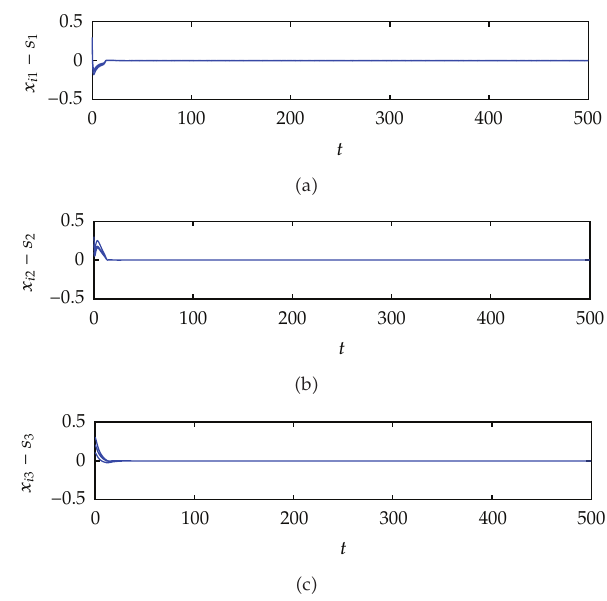
Figure 2: Synchronization errors x ir − s r (cid:2) 1 ≤ i ≤ 3 , 1 ≤ r ≤ 3 (cid:3) of network (cid:2) 4.1 (cid:3) for pinning the first two